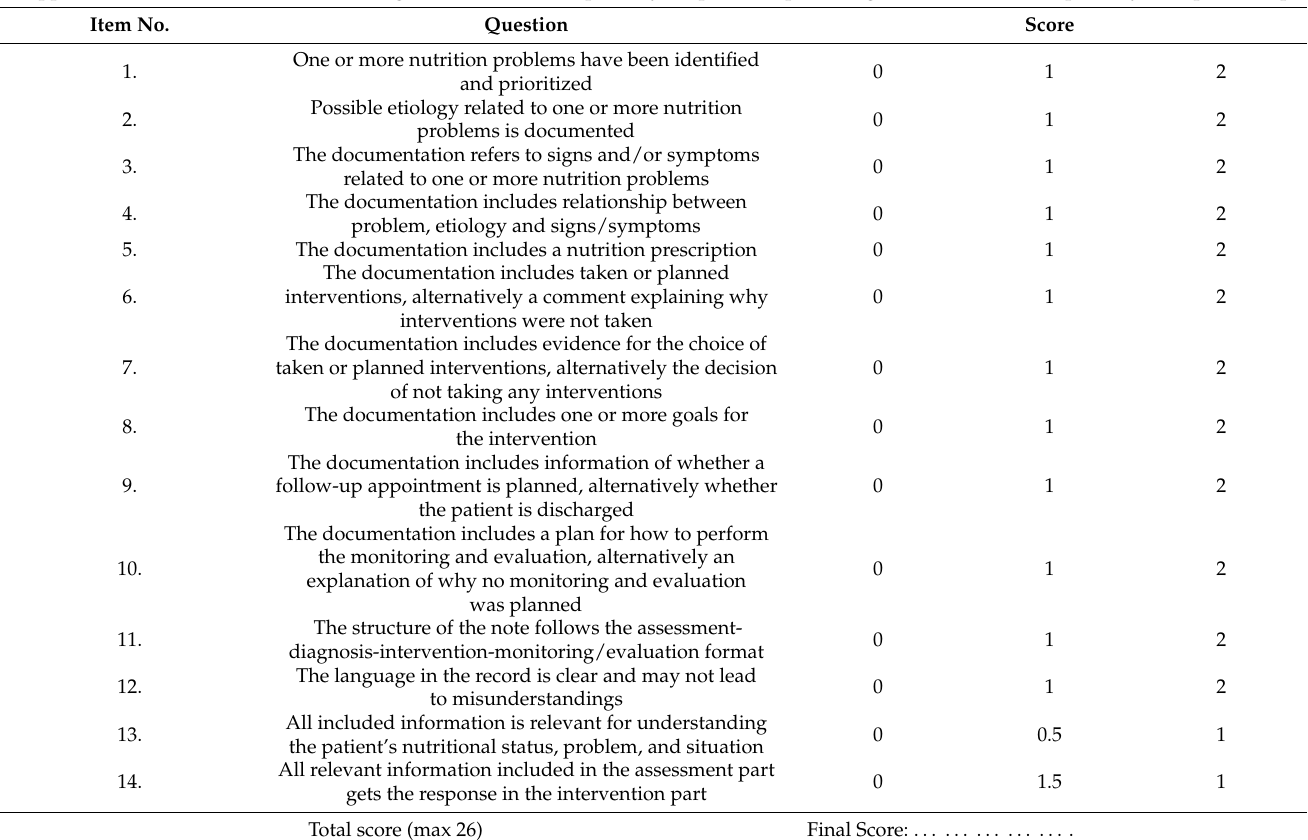
Table 1. Diet-NCP-Audit instrument. This table was adapted with permission from the author and publisher * [7]. Are the Following Statements Consistent with the Medical Record Reviewed? Answer in Accordance with the Scoring Scale, and with Support of the Associated Manual. Scoring Items 1–12: Yes = 2 p, Partly = 1 p, No = 0 p; Scoring items 13–14: Yes = 1 p, Partly = 0.5 p, No = 0 p Item